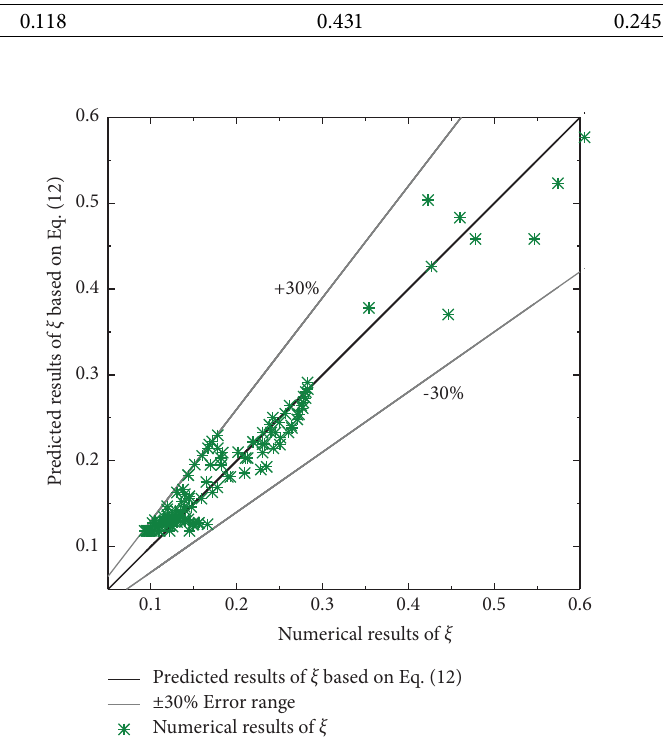
Figure 14: Comparison of predicted and numerical results of ξ in vertical L-shaped pipes.